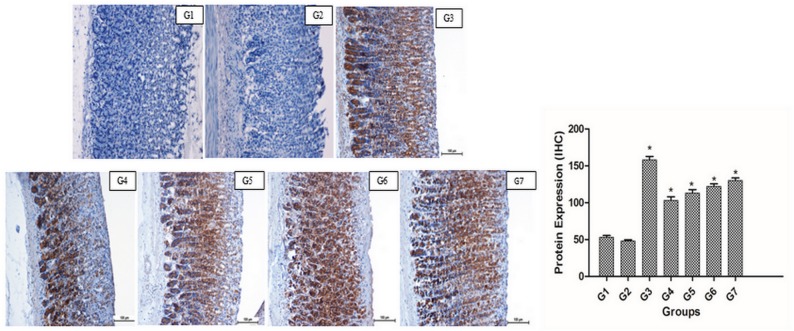
Effects of V. pubescens on immunohistochemical staining (HSP70 staining) of stomach wall in ethanol-induced gastric mucosal injury in rats.(G1) (Normal control group); (G2) (Ulcer control group); (G3) (Omeprazole); (G4) (62.5 mg/kg), (G5) (125 mg/kg), (G6) (250 mg/kg) and (G7) (500 mg/kg) of V. pubescens extract. HSP70 protein was over-expressed in rats pre-treated with omeprazole or V. pubescens extract (brown color shows over-expression of HSP70 protein) (magnification 20×). There were 6 rats in each group of experiment. The Image J program was used to evaluate protein expression. All values are expressed as the means ± the standard error of mean. The mean difference was significant at the p < 0.05 level compared to the cancer control group.